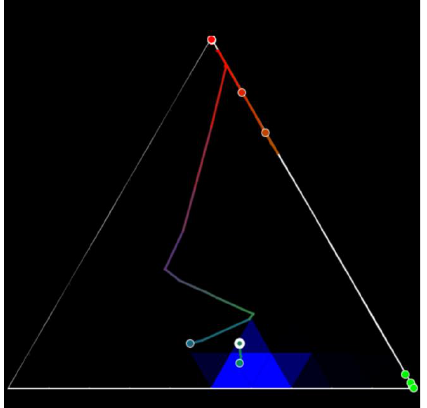
Figure 20. Trilinear coordinate pattern. It can be used to determine the value of the parameters of an object located on a triangle. The red dot denotes an example of data in trilinear coordinates [62].